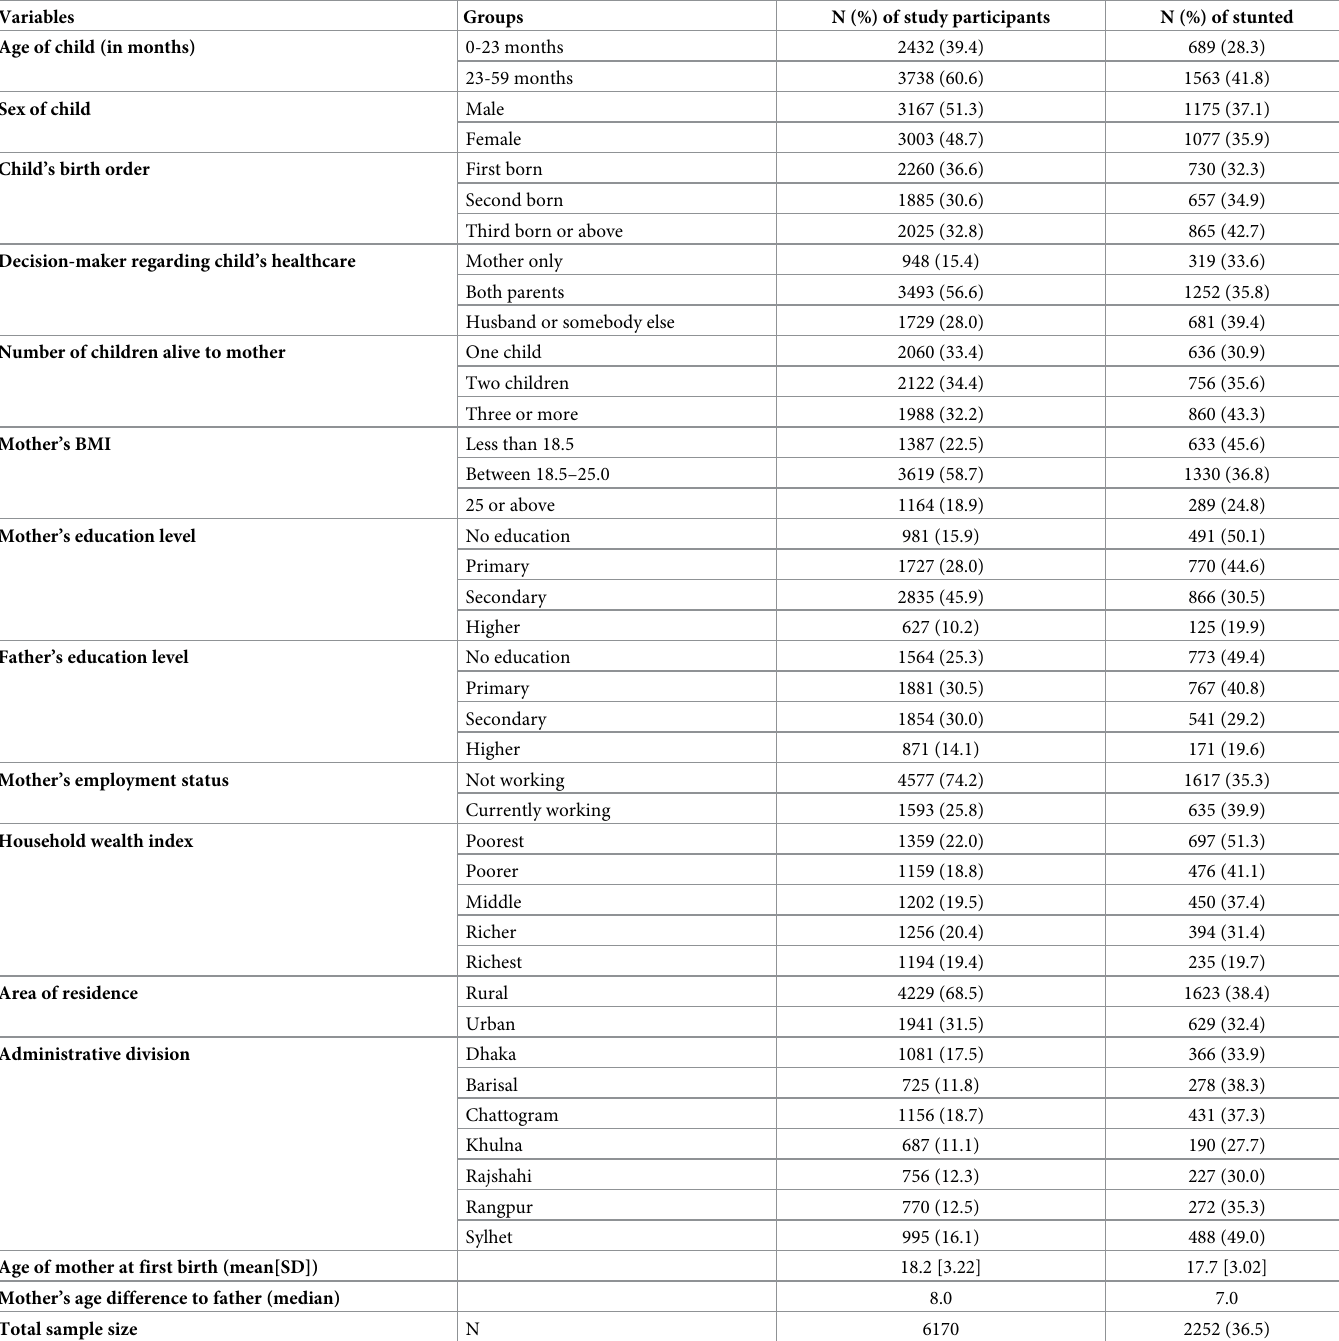
Table 1. Distribution of stunting by sociodemographic variables (categorical and continuous) among children aged 0-59